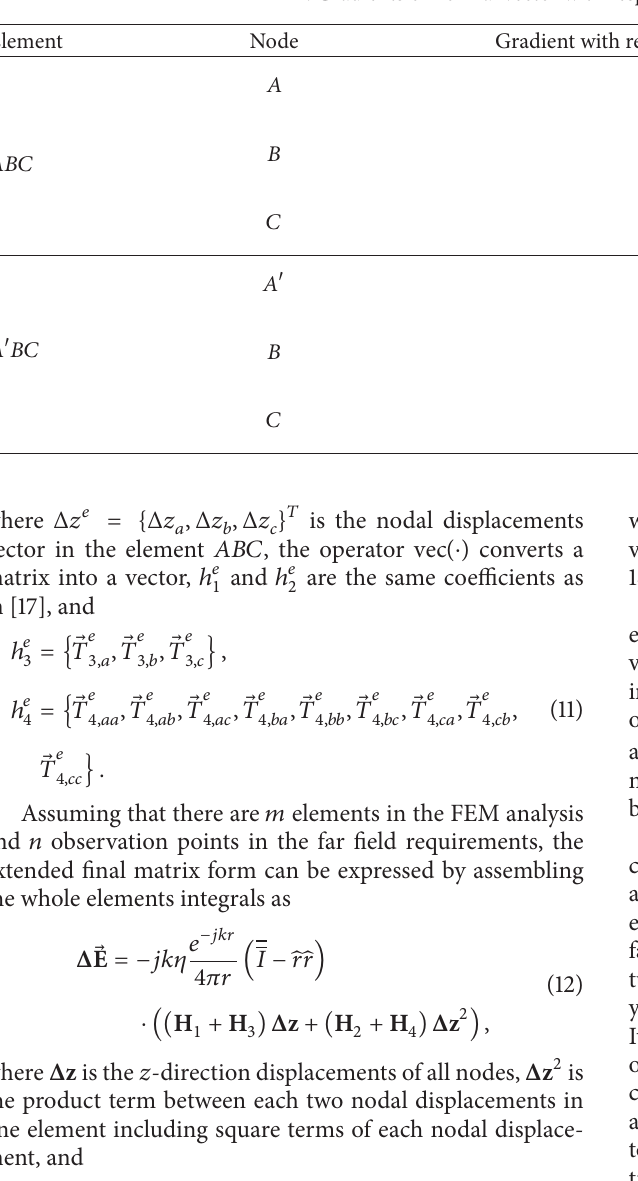
Table 1: Gradients of normal vector with respect to triangular nodal